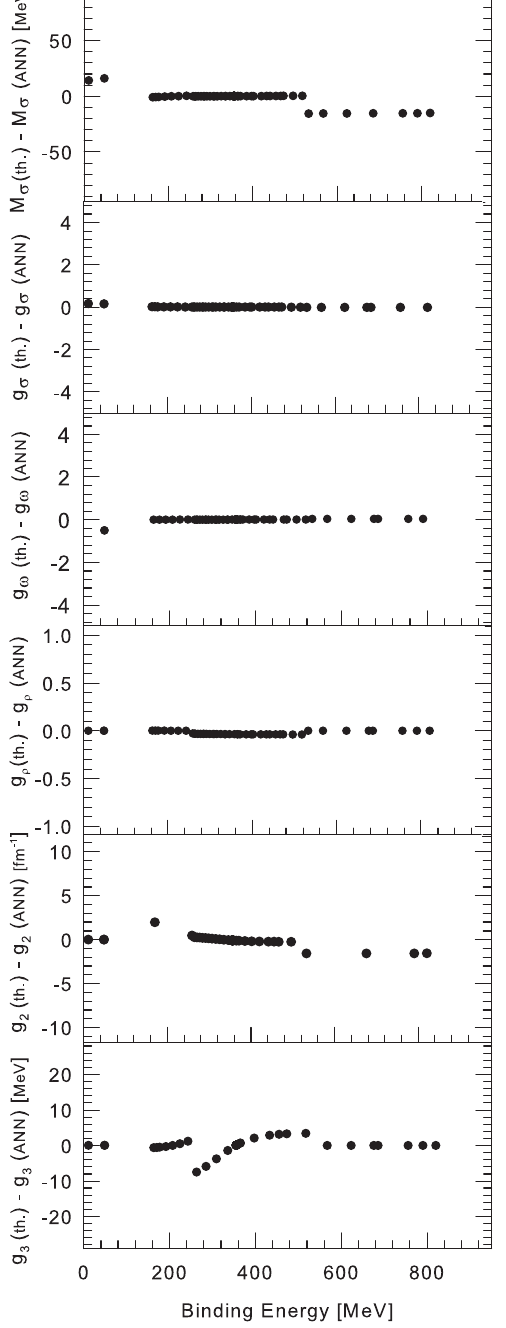
Figure 1. The differences between input and output data obtained from test stage for non-linear RMF model parameters ( M σ , g σ , g ω , g ρ , g 2 and g 3 ) by considering 58